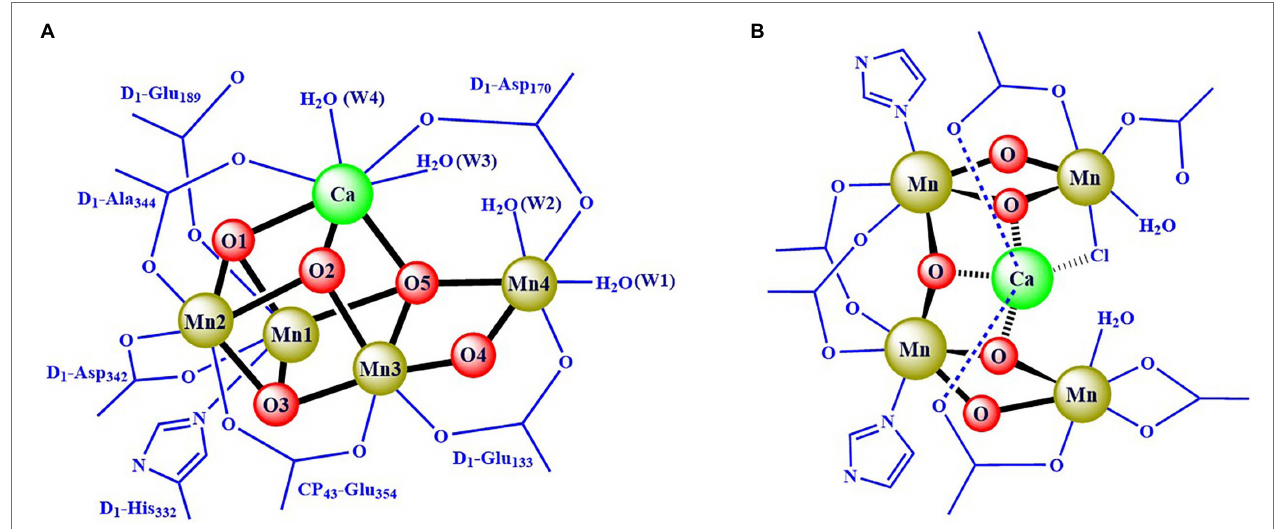
FIGURE 2 | Scheme for the structure of the OEC (Umena et al., 2011) (A) and the theoretical model (Zhang et al. 1999) (B)